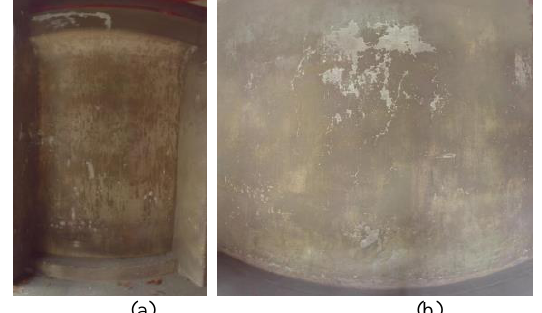
Figure 7. RGB images of some inner walls of the pagoda: (a) Wall 1; (b) wall